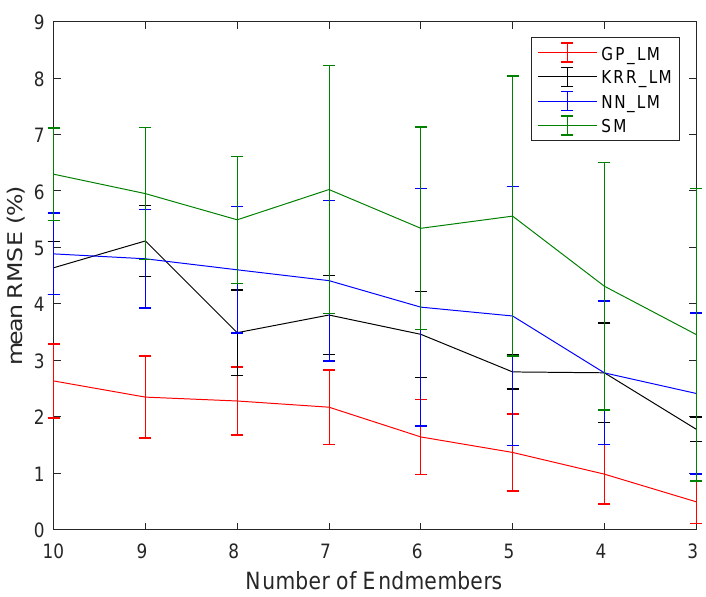
Figure 7. RMSE (20 runs) for the methods using the proposed strategy (GP_LM, KRR_LM, and NN_LM) and SM as a function of the number of endmembers.